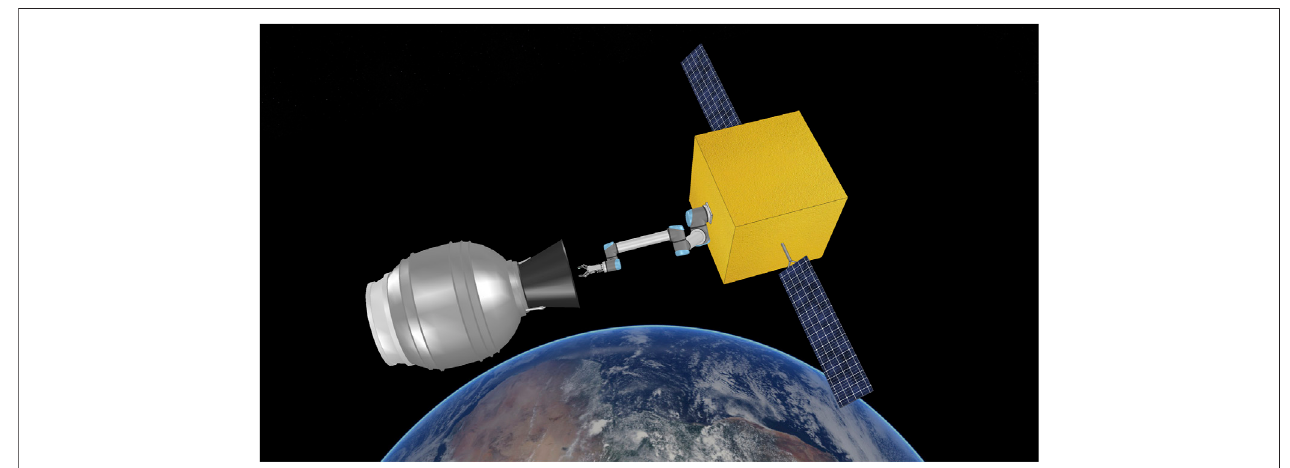
FIGURE1| Simulation scene ofachasingspacecraftandaspent STAR-48rocketstage.Inthispaperweevaluatehowaroboticgrippercouldbeused tocapture space debris by analysing the grasp stability of the gripper-nozzle bell grasp.